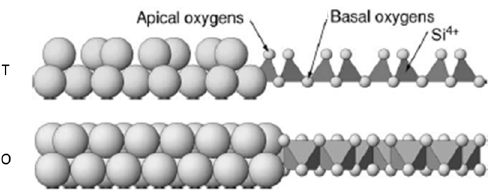
Figure 1. The tetrahedral (T) and octahedral (O) sheet represented with the sphere-packing ( left ) and polyhedral ( right ) model. Adapted from [21].